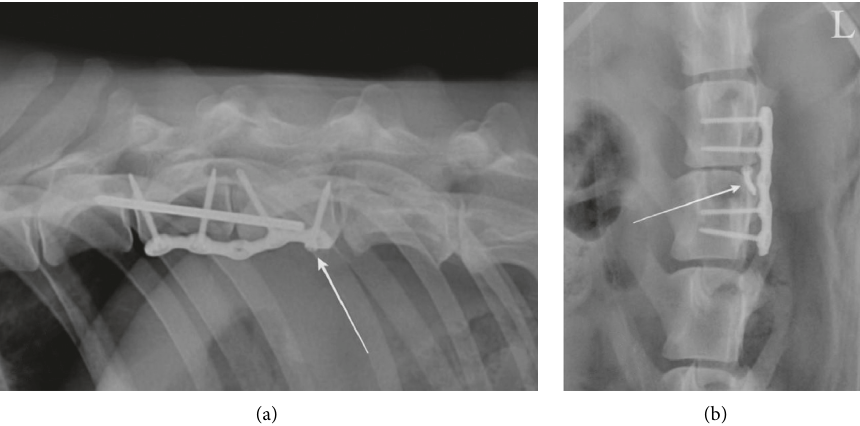
Figure 8: Lateral radiograph of the caudal thoracic spine (a) and ventrodorsal radiograph of the lumbar spine (b) three weeks post- operatively of two different dogs showing (a) slight withdrawal of most caudal screw (arrow) and (b) bending of facet screw